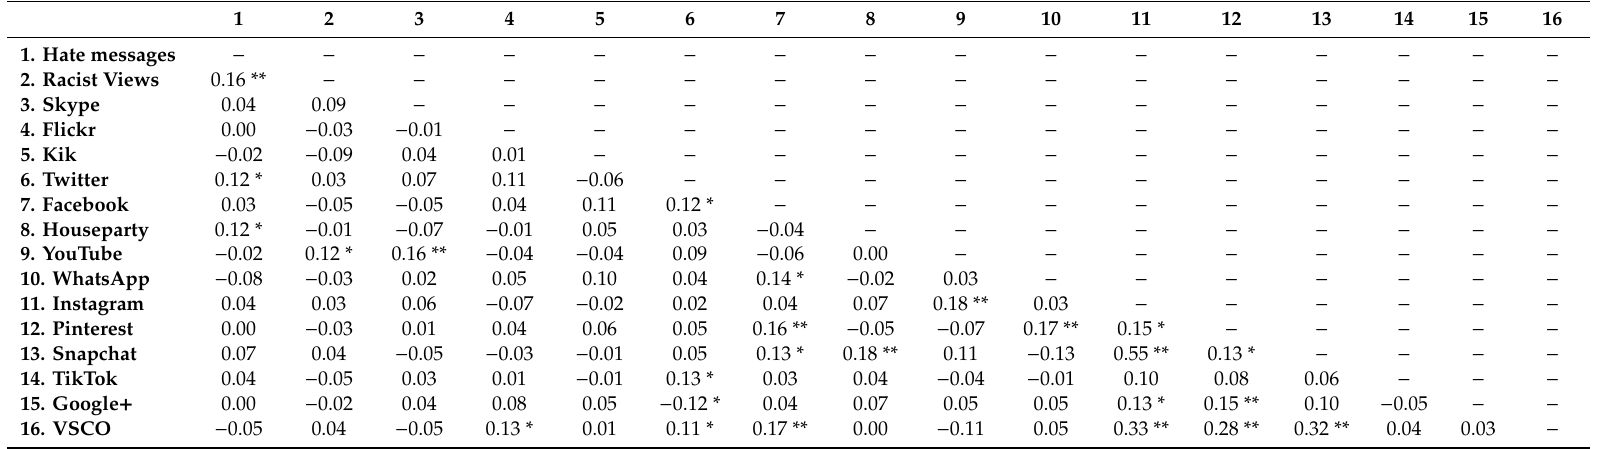
Table 3. Spearman’s Correlation Matrix for Social Media and Hate